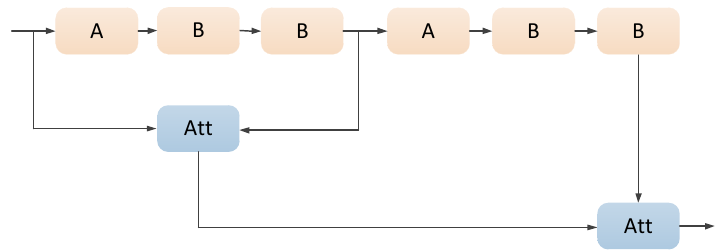
Figure 2. Illustration of the multiple receptive field feature integration. A and B represent two differ- ent types of residual modules, respectively, while Att represents the attention-based feature fusion.